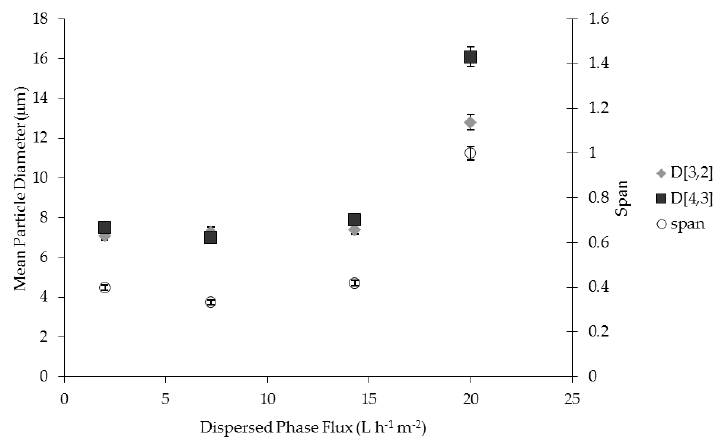
Figure 1. The effect of dispersed phase flux on particle size and particle size distribution of water-in-oil (W/O) emulsion prepared by using pulsed back-and-forward membrane emulsification (shear stress: 5.8 Pa, membrane pore size: 3.1 µm).